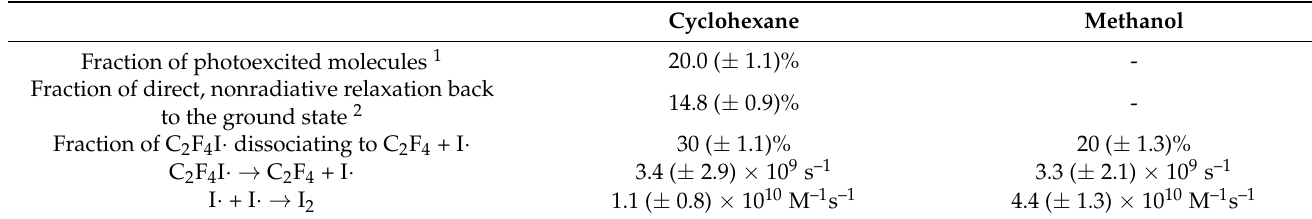
Table 1. Fitting parameters obtained from global fitting analysis of C 2 F 4 I 2 in cyclohexane in comparison with those from C 2 F 4 I 2 in methanol. Errors for fitting parameters shown in